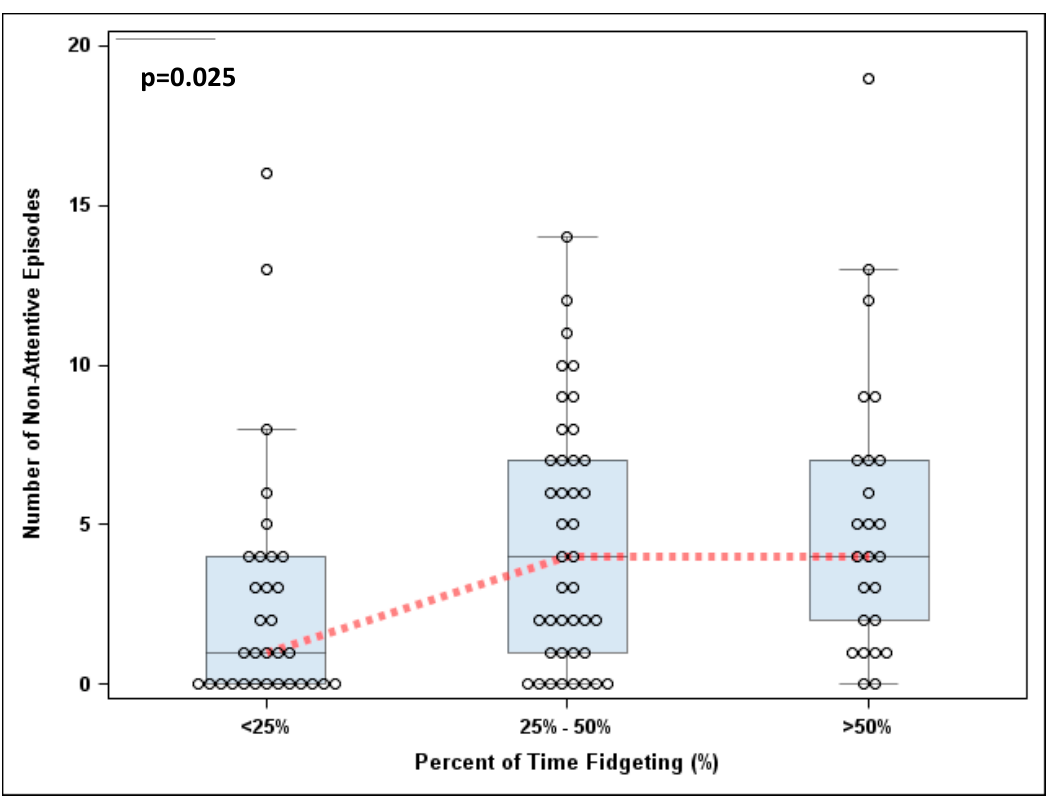
Figure 2. The number of non-attentive episodes by fidgeting categories at baseline.